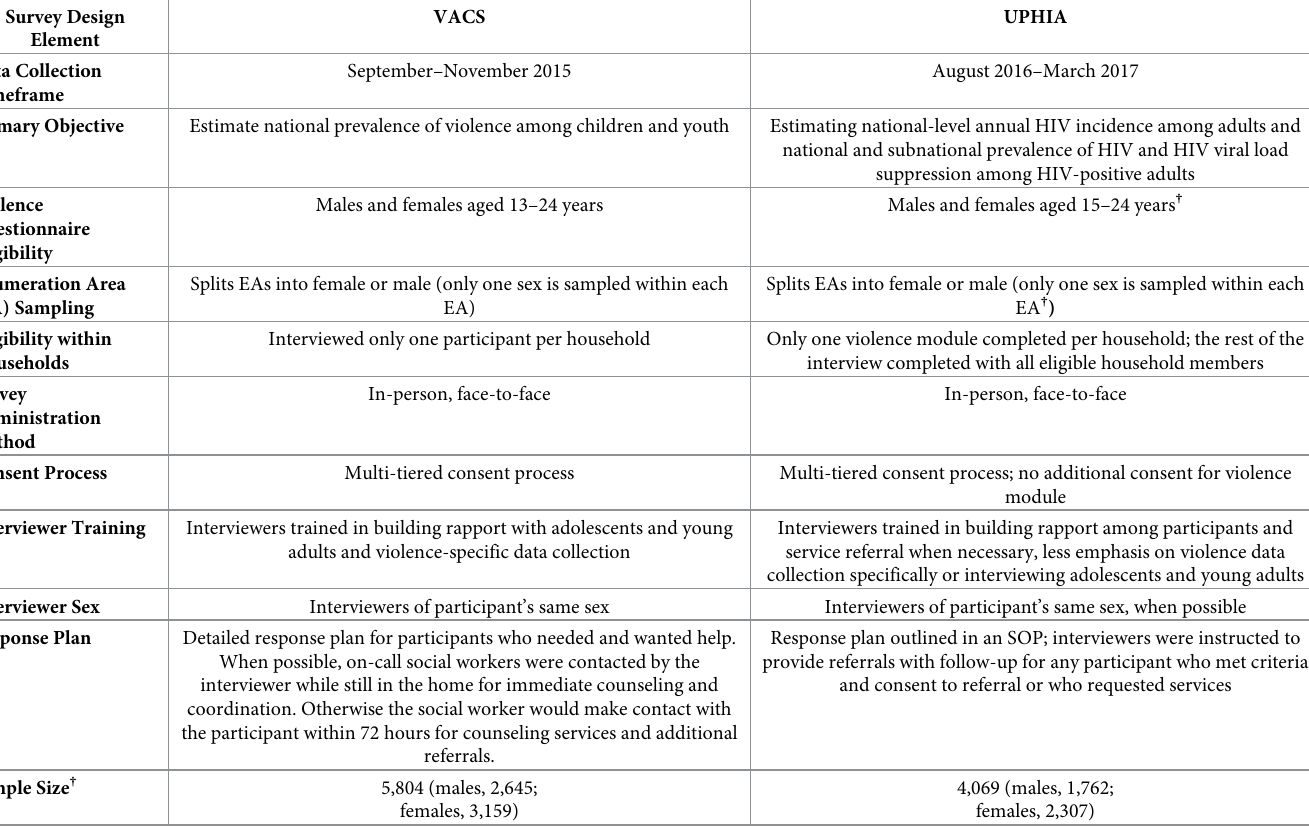
Table 1. Methods and sampling structure of Uganda Population-based HIV Impact Assessment (UPHIA 2016–2017) and Uganda Violence Against Children Sur- vey (VACS